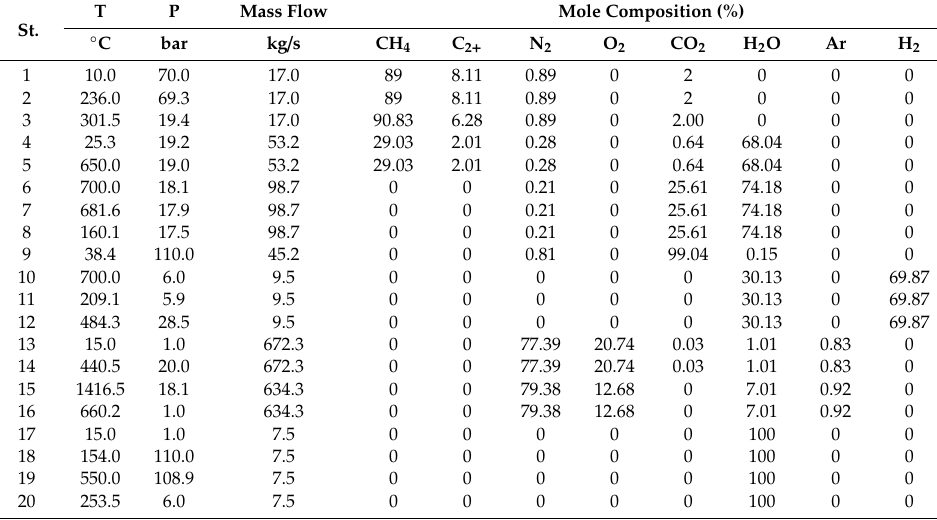
Figure 6. Schematic of case 4 (part H 2 is used in combustor). Stream numbers refer to stream details listed later in Table 3. Table 4. Stream data of case 5 with 2P-HX (power production) in Figure